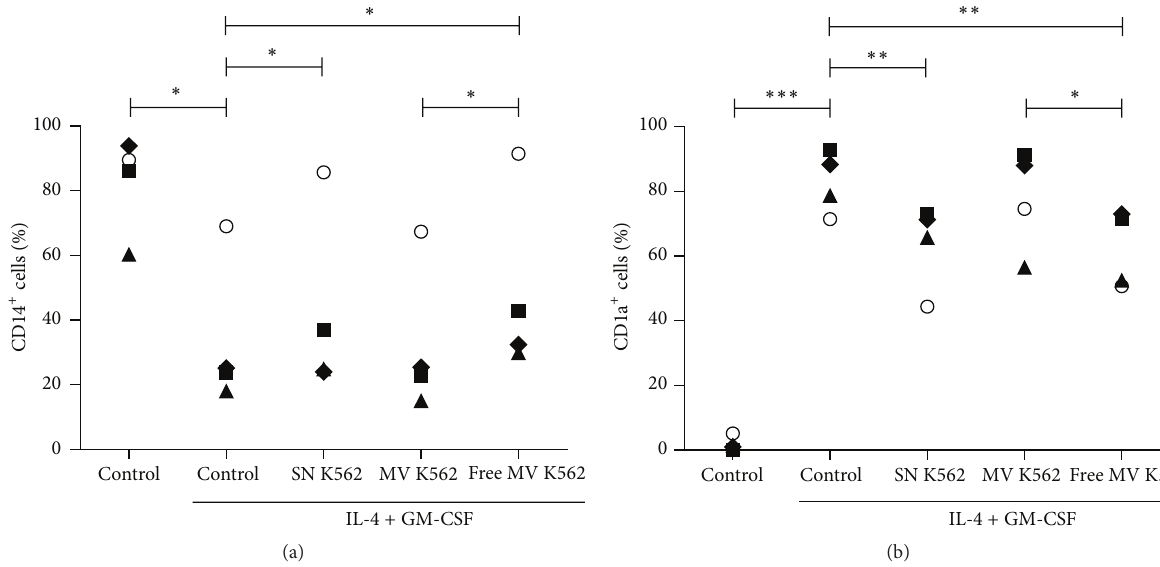
Figure 2: Leukemic cell microvesicles influence on dendritic cell differentiation. Mononuclear cells were obtained after gradient density from buffy coats of healthy individuals. After 2 h of adhesion, lymphocytes were removed and monocyte cultures were stimulated with IL-4 and GM-CSF (50ng/mL) to induce dendritic cell differentiation. K562 supernatants (SN K562) were obtained after 3 days of cell culture in RPMI plus 10% of fetal bovine serum (FBS) followed by filtering (0.22 𝜇 m). Part of the tumor supernatant was centrifuged twice at 100000 g for 1h to purify microvesicles. After this process, two supernatants were obtained: K562 supernatant only with microvesicles resuspended in the same original volume of medium (MV K562) and K562 supernatant with all the other products except microvesicles (free MV K562). Supernatants were added (10% of final volume) at the beginning of monocyte culture and remained until the end (5 days). Afterward, cells were stained with anti-CD14 FITC and anti-CD1a PE and data were acquired in a FACS Calibur. Graphs show the percentage of CD14 + (a) and CD1a + (b) cells. Each individual analyzed in different conditions is represented by one symbol. ∗ 𝑝 ≤ 0.05 ; ∗∗ 𝑝 ≤ 0.01 ; ∗∗∗ 𝑝 ≤ 0.001 . 𝑛 = 4